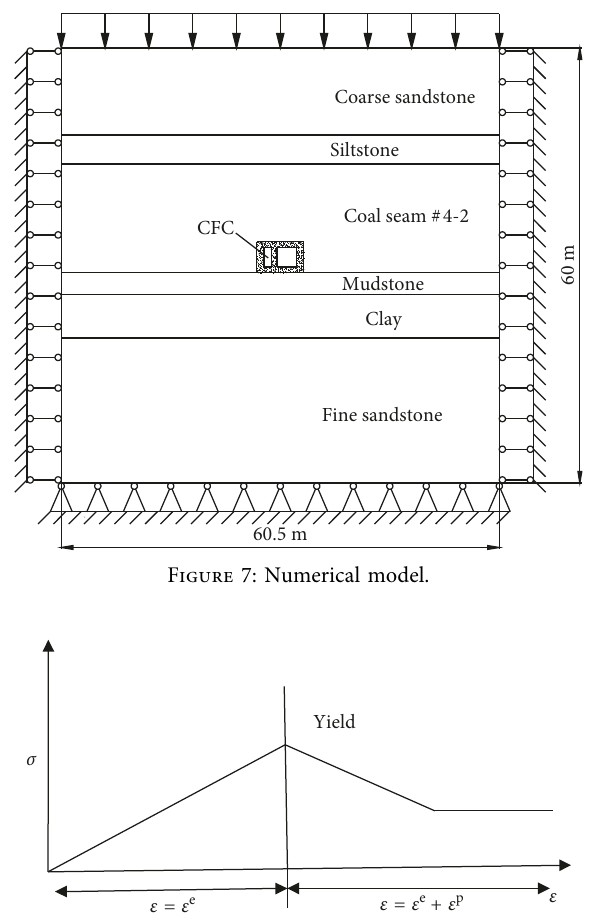
Figure 8: Strain-softening constitutive model [33], where ε e is the elastic strain and ε p is the plastic